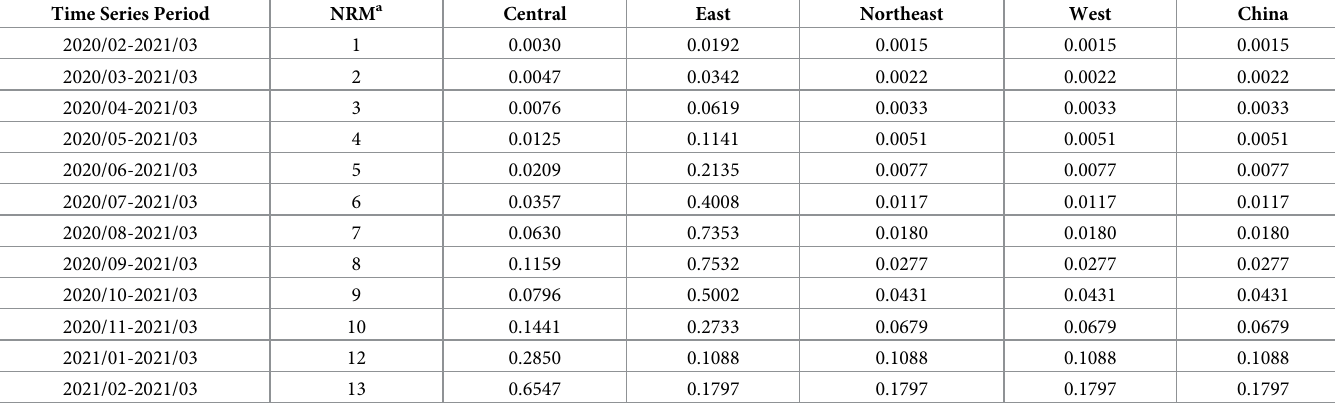
Table 2. Recovery time and P values of the Wilcoxon matched-pairs signed ranks sum test on actual and predicted time series of hospital visits per capita in main- land